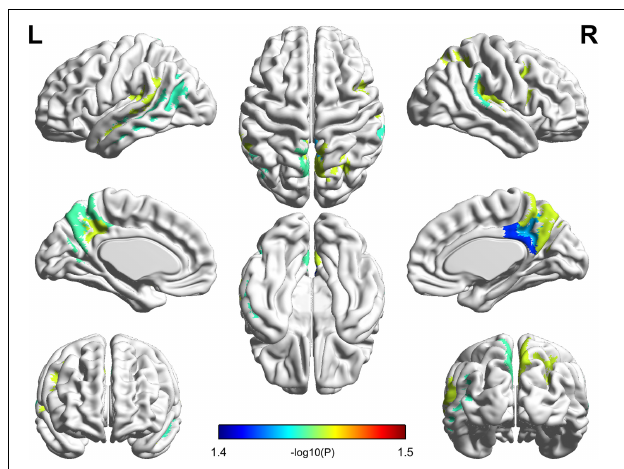
FIGURE 2 | Compared with healthy controls, patients with presbycusis showed decreased volume in the left superior temporal sulcus; the right posterior cingulate cortex and transverse temporal sulcus; and the bilateral precuneus, temporal plane of the superior temporal gyrus and subparietal sulcus ( p < 0.05, false discovery rate